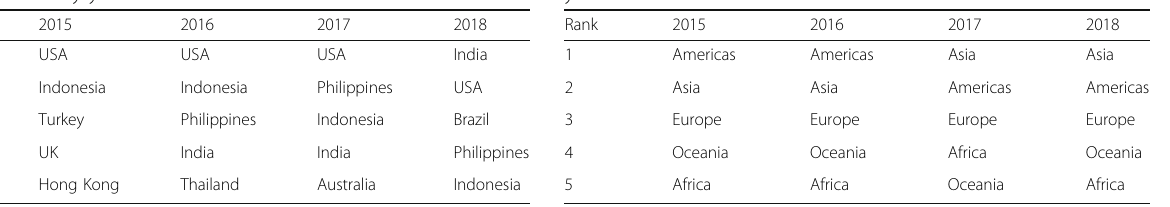
Table 4 The journal ’ s access ranking across five continents